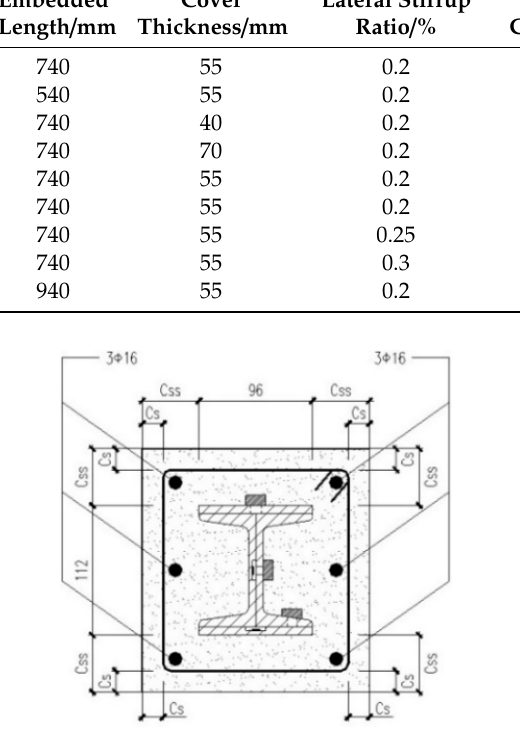
Figure 1. Section design of specimens.